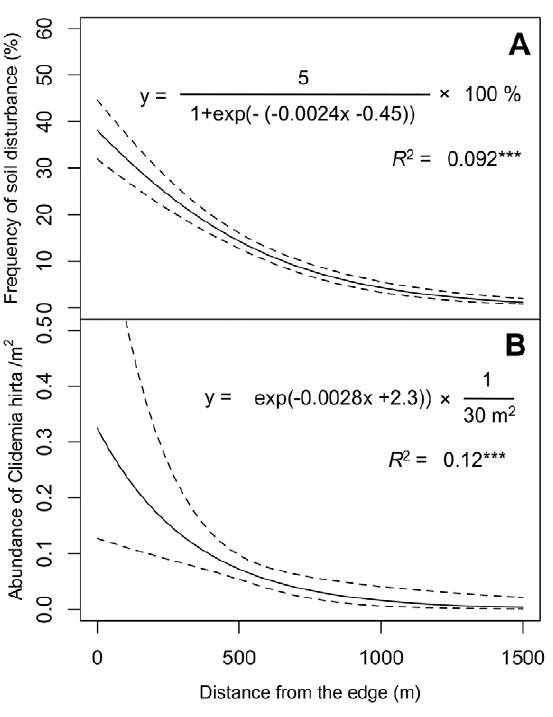
Figure 5. Estimated decline in soil disturbance (A) and Clidemia hirta abundance (m-2) (B). Soil disturbance is given as the percentage of 1 m segments affected per 5 m section. The broken lines represent confidence intervals.